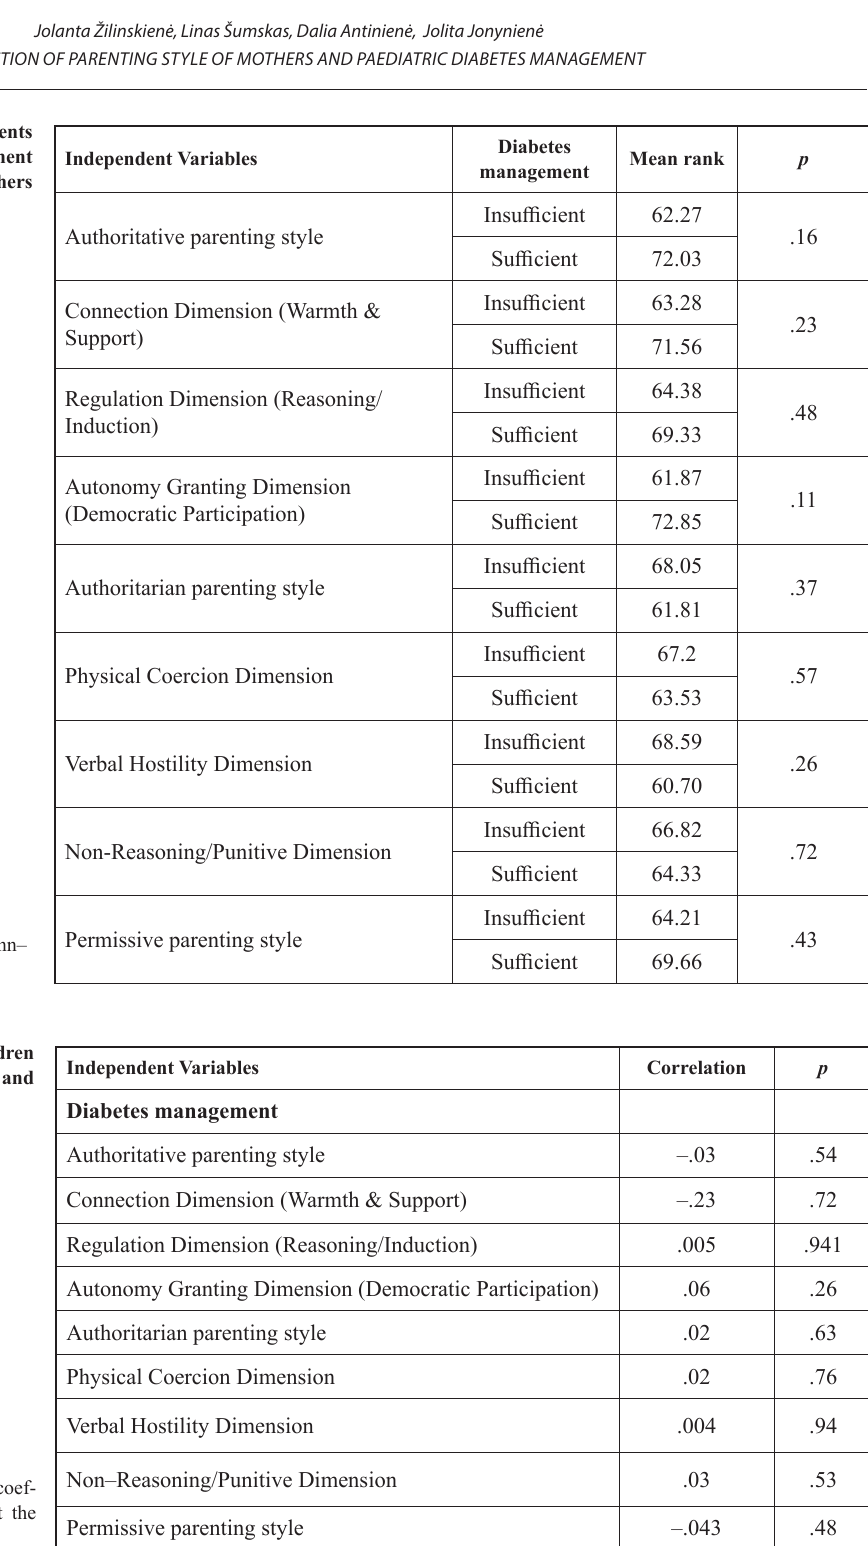
Notes. Spearman linear correlation coef- ficient. Correlation is significant at the .05 level